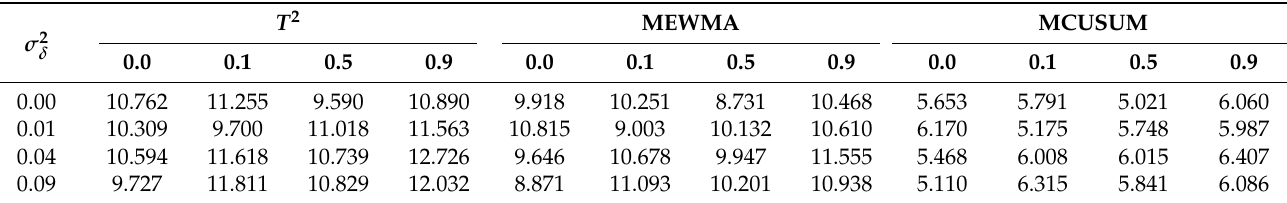
Table 1. The UCL values for three proposed control charts when ARL 0 (cid:39)